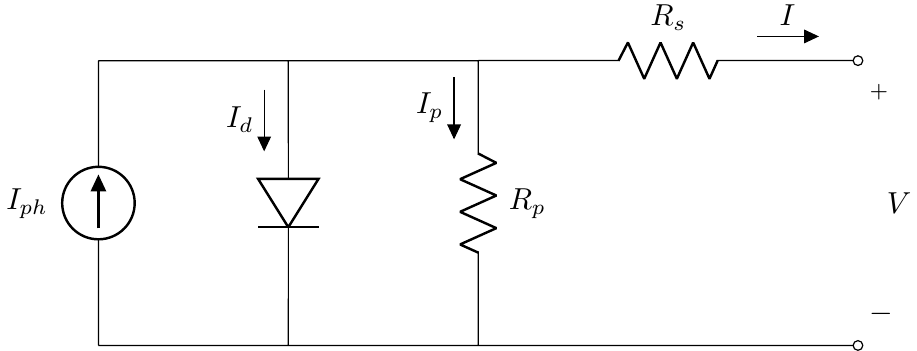
Figure 1. The single-diode model equivalent circuit of a photovoltaic